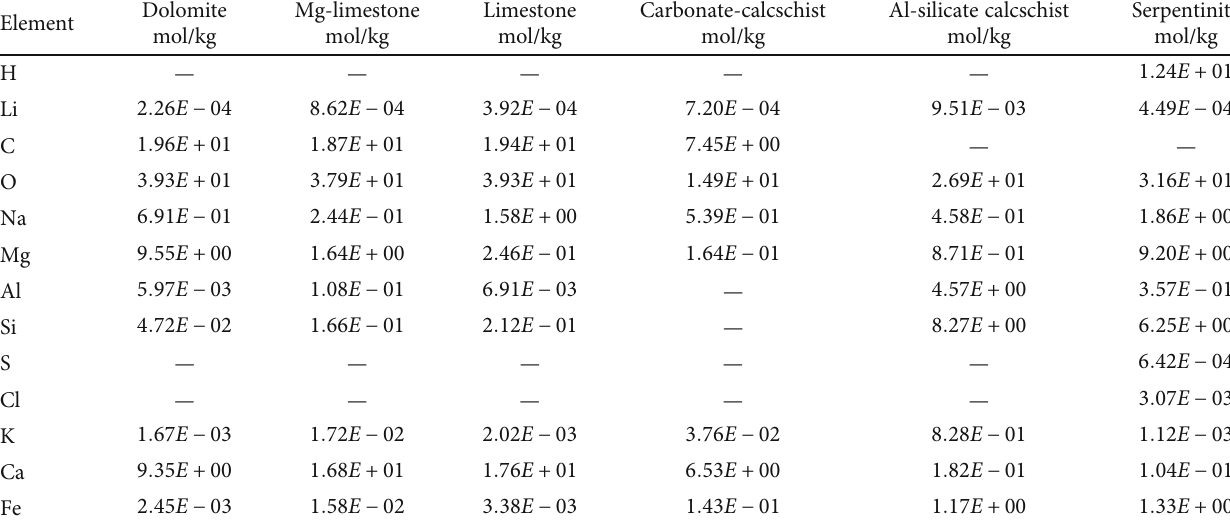
Table 1: Elemental composition of the six solid reactants considered in reaction path modeling of rock dissolution.